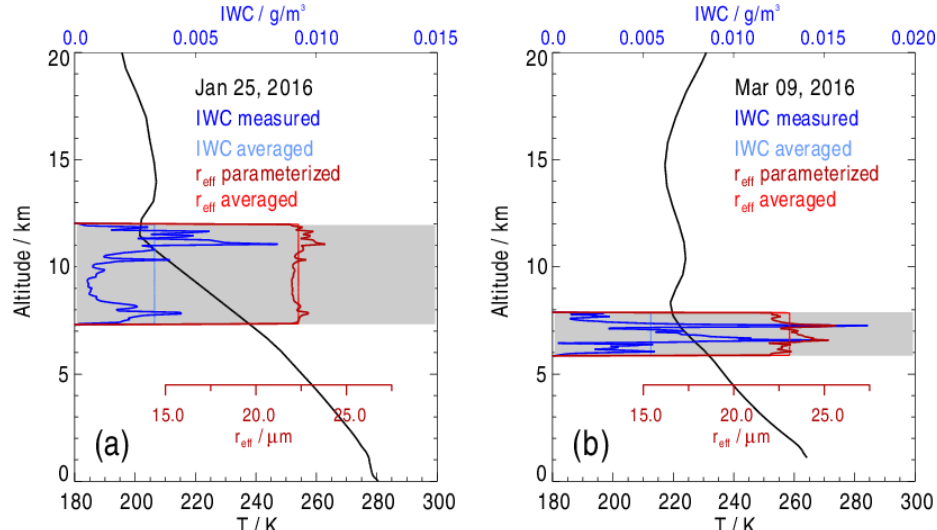
Figure 6. Vertical profiles of the measured ice water content (IWC, dark blue) on (a) 25 January and (b) 9 March 2016 and the effective radius ( r eff , dark red) derived from a parameterisation after Liou et al. (2008) describing r eff as a function of the IWC. Vertical averages of the IWC and r eff are indicated using light blue and light red lines respectively. Dark lines show the temperature profiles, and grey shading illustrates the total vertical extent of the measured ice